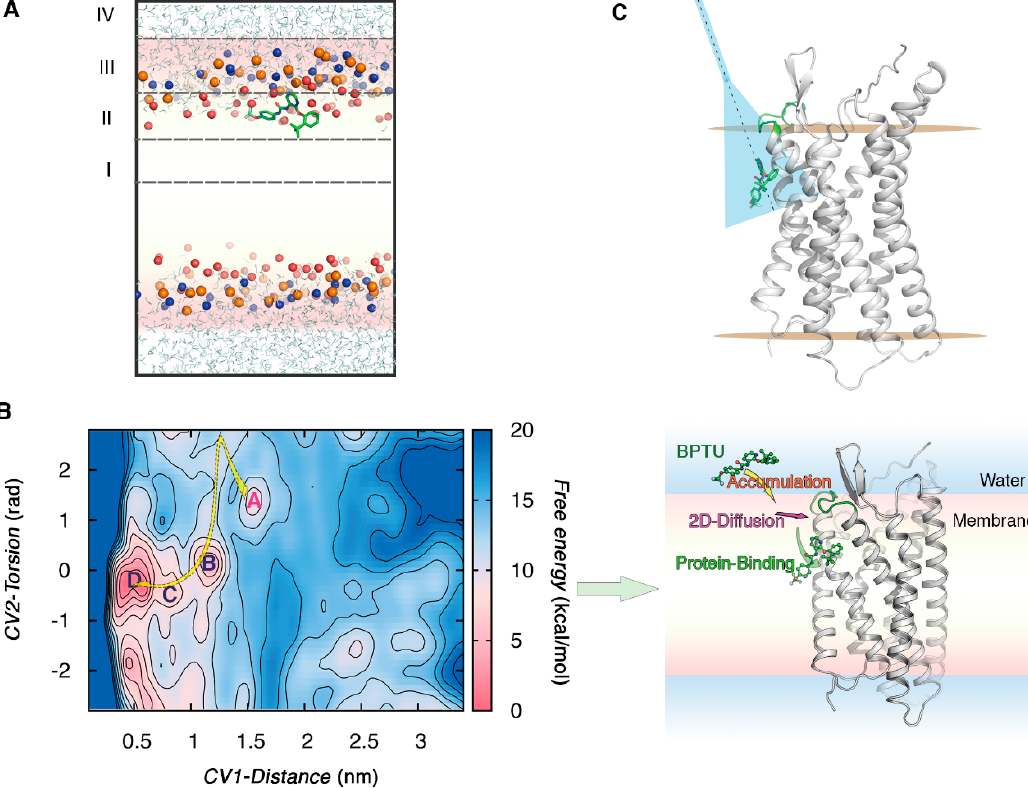
Figure 1. The mechanism of BPTU binding to the receptor–lipid interfacial pocket of P2Y 1 purinergic receptor (P2Y 1 R) investigated by multiple computational simulation methods. ( A ) 1-(2-(2-(tert-butyl) phenoxy)pyridin-3-yl)-3-(4-(trifluoromethoxy)phenyl)urea (BPTU) molecules spontaneously penetrate and stay in Region II of the bilayer in unbiased molecular dynamics simulations. ( B ) The free energy surface (FES) underlying the BPTU–P2Y 1 R association process and the proposed energetically favorable binding pathway. Four major energy minima found on the FES were labeled A–D. ( C ) The diagram of the funnel metadynamics simulation.